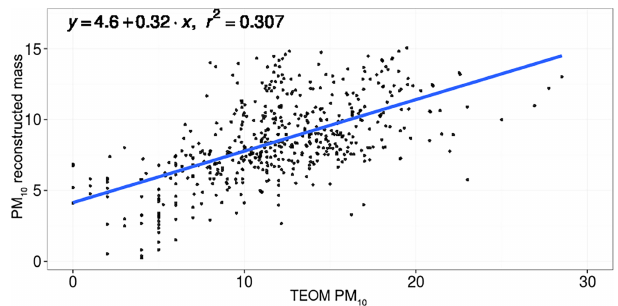
Figure 2. Scatter plot of TEOM PM 10 mass concentration as a function of the PM 10 reconstructed mass concentration for the ADRIMED